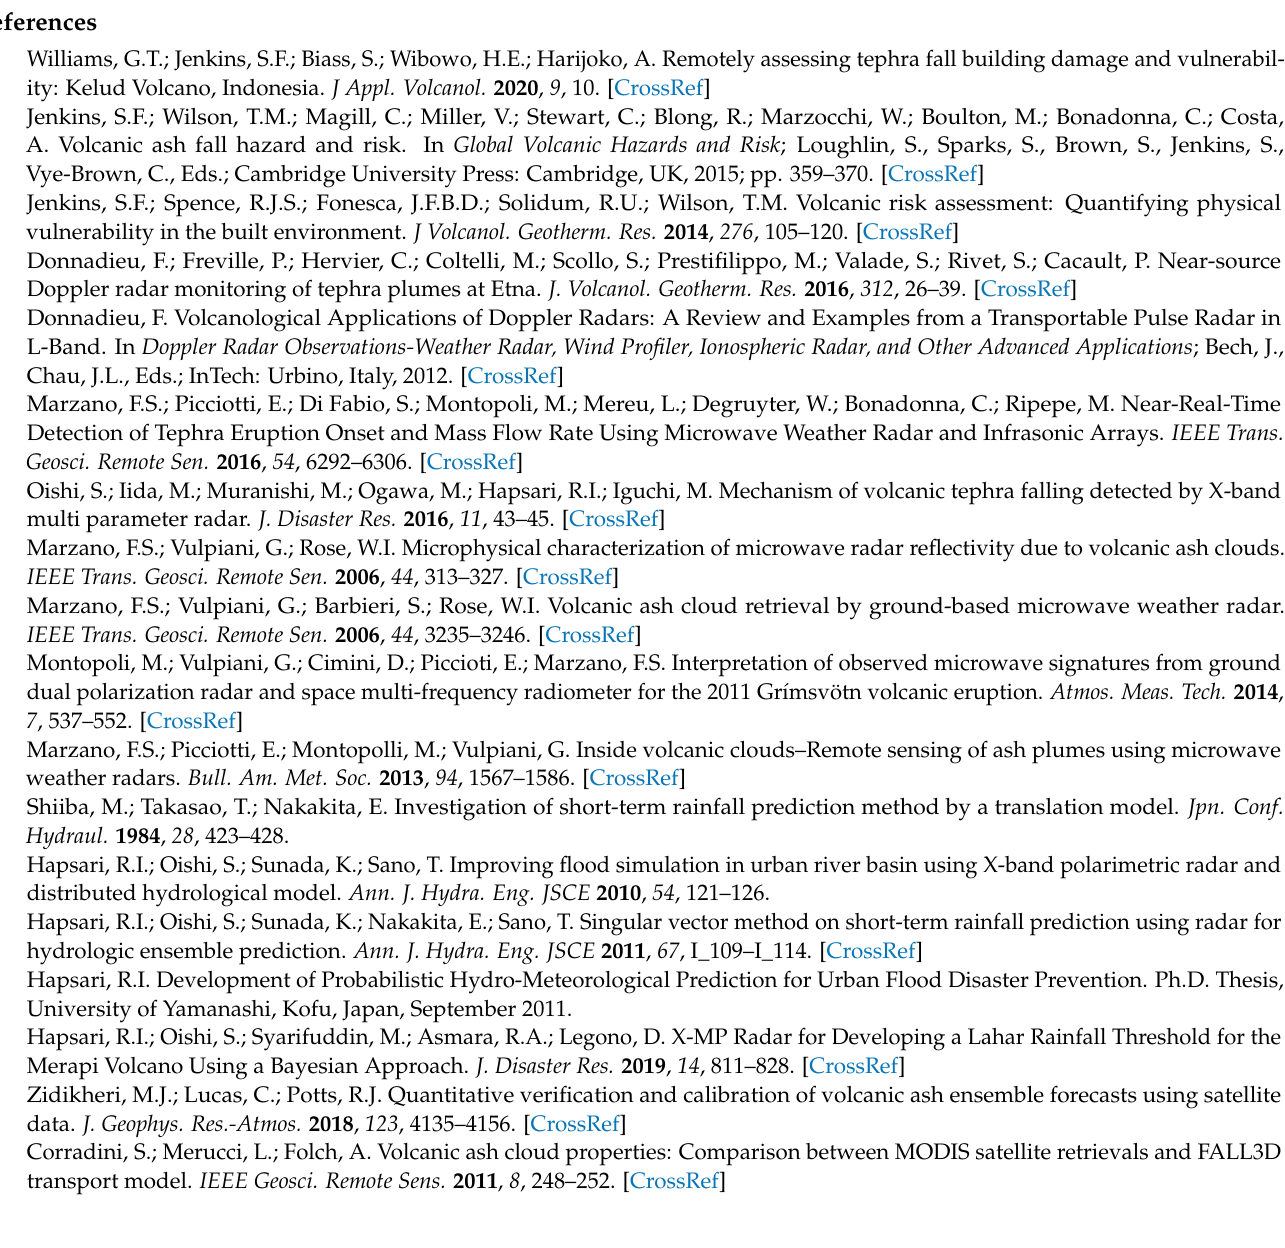
Figure A5. Number of missed and false events of ensemble members and the mean ensemble for M05 ( a ) and M06 ( b